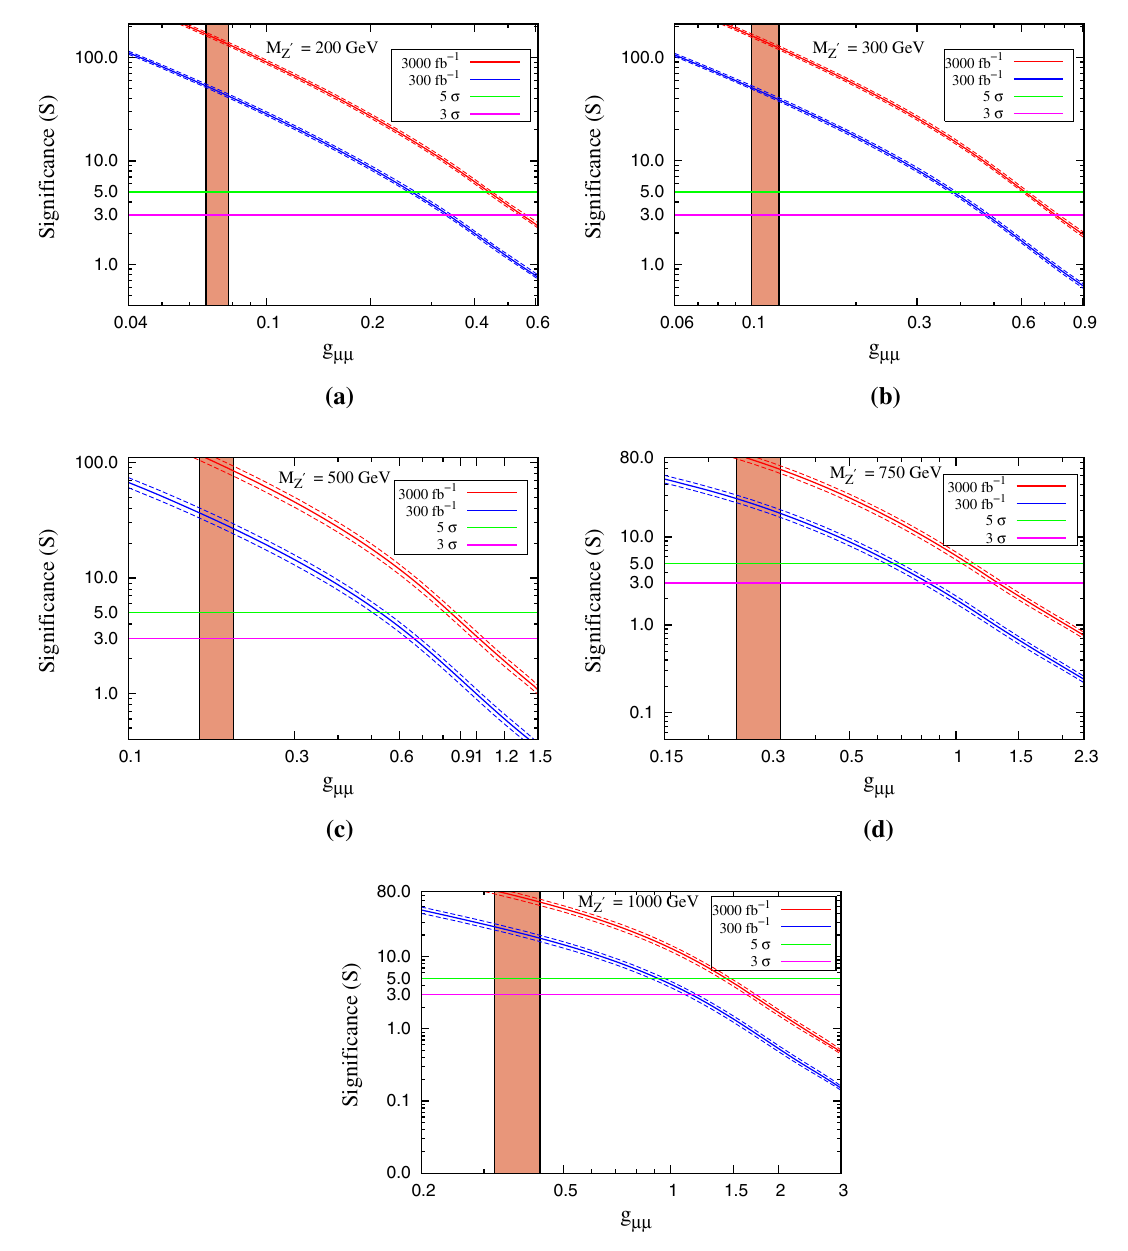
Fig. 8 Significance vs. g μμ for M Z (cid:2) = 200 ( 8 a ), 300 ( 8 b ), 500 ( 8 c ), 750 ( 8 d ) and 1000 ( 8 e ) GeV for μ + μ − + 1 b ( 2 b ) channel at TeV. The dashed lines represent the error band in Significance curves